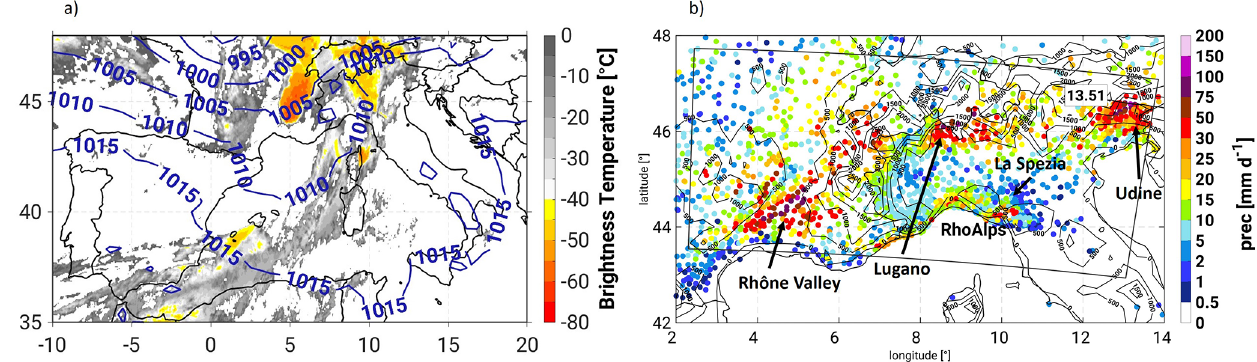
Figure 2. Synoptic overview of IOP6. (a) Brightness temperature of the MSG-SEVIRI instrument (MSG-0 degree, all-sky radiances, https: //www.eumetsat.int/, last access: 23 June 2021) and isolines of mean sea level pressure simulated by COSMO (7km) on 24 September 2012 at 06:00UTC. (b) 24-hourly accumulated precipitation from the HyMeX RG data set. The dark boxes FR and RhoAlps denote the investigation areas.